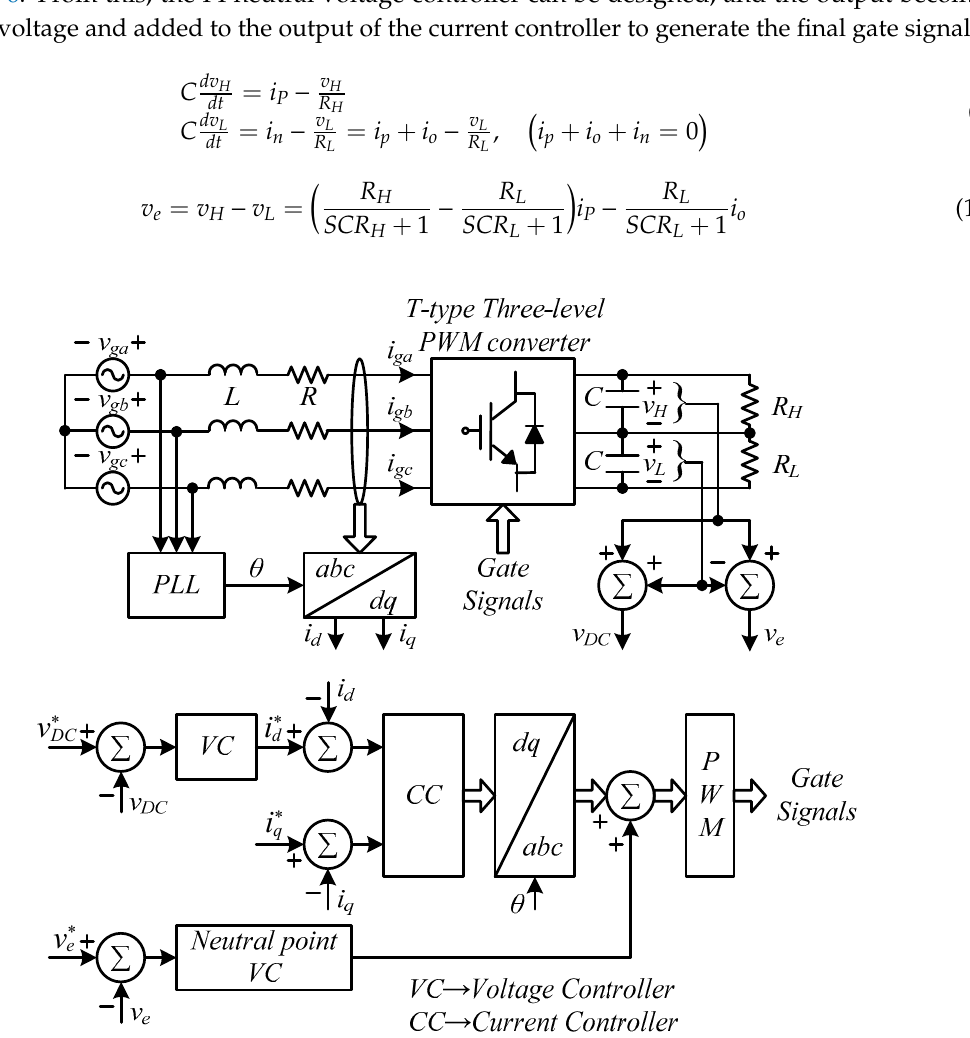
Figure 5. Control block diagram of the T-type three-level PWM converter system.